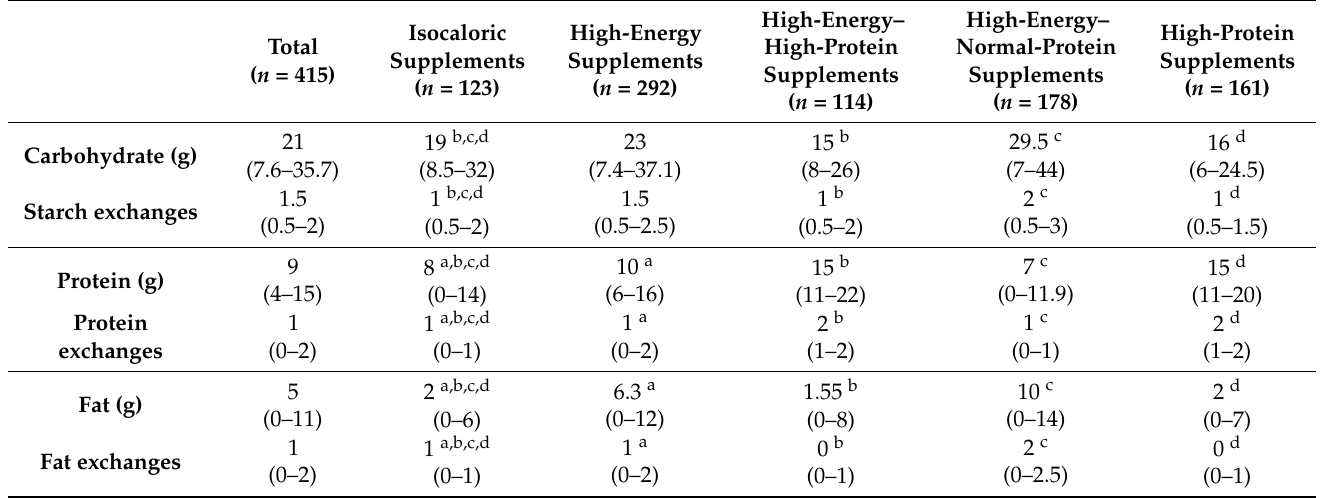
Table 1. Macronutrients and diabetic exchanges per category of